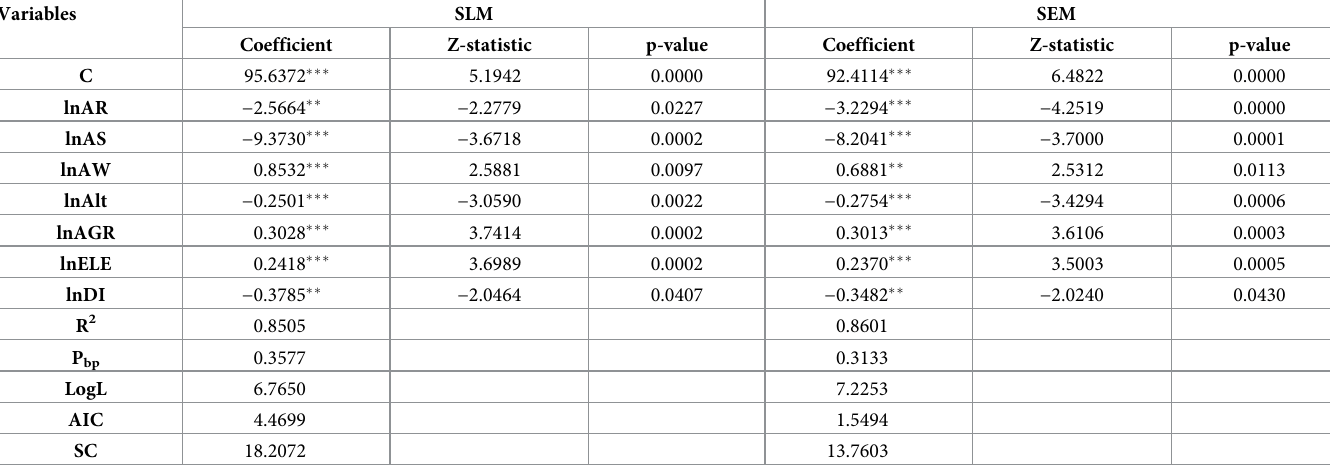
Table 4. Parameter estimation and test results of the spatial econometric